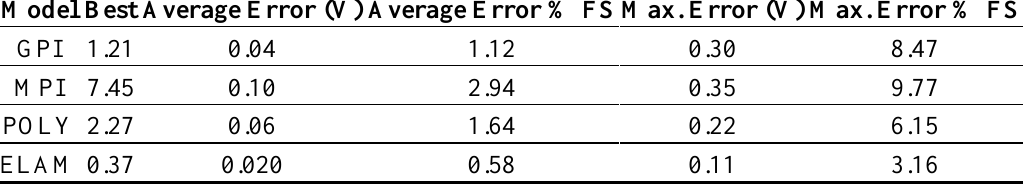
Figure 10. Models for ascending curves. ( a ) GPI model with n = 4 play operators; ( b ) MPI model with third-order polynomial and n = 10 OSP operators; ( c ) POLY model with sixth-order polynomial; ( d ) ELAM model. Table 5. Average errors and maximum errors of hysteresis models for ascending